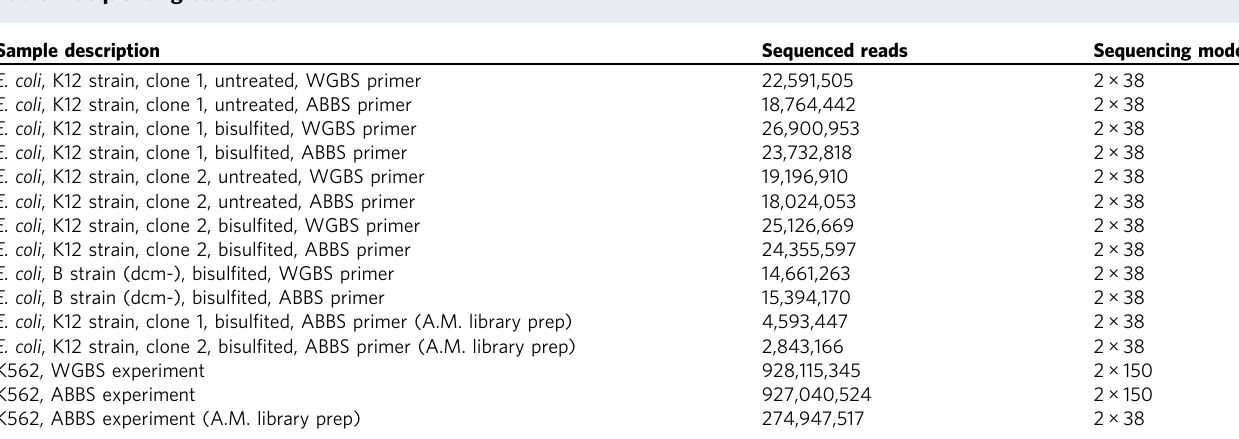
See Table 1 for sequencing